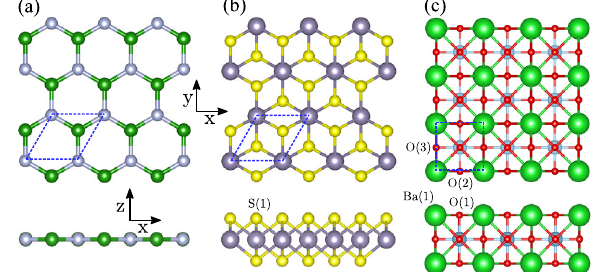
FIG. 3. Atomic structure of the simulated 2D materials: BN (a), SnS 2 (b), and BaTiO 3